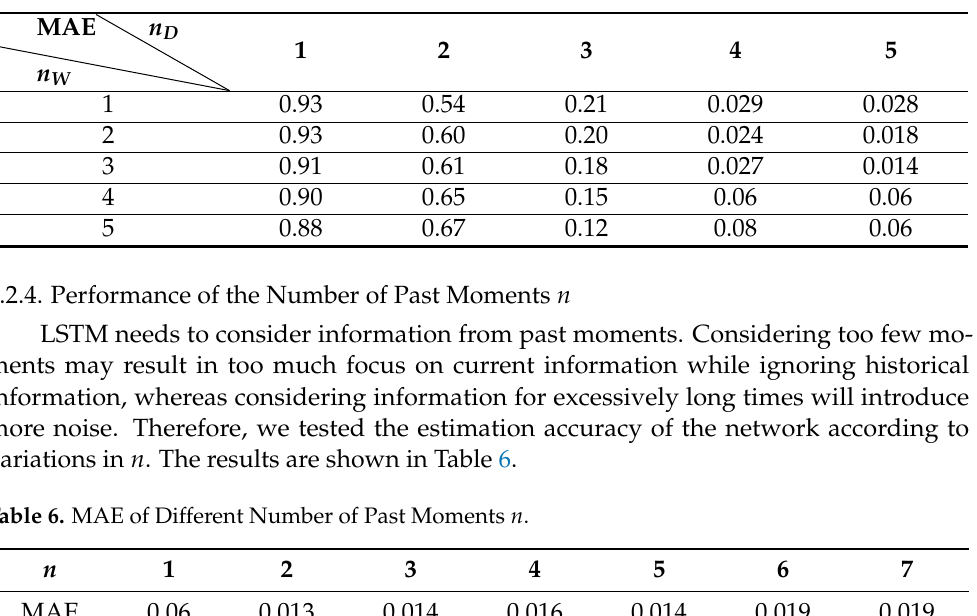
Table 5. Performance According to Differences in the Number of Neurons in Embedding Layers.